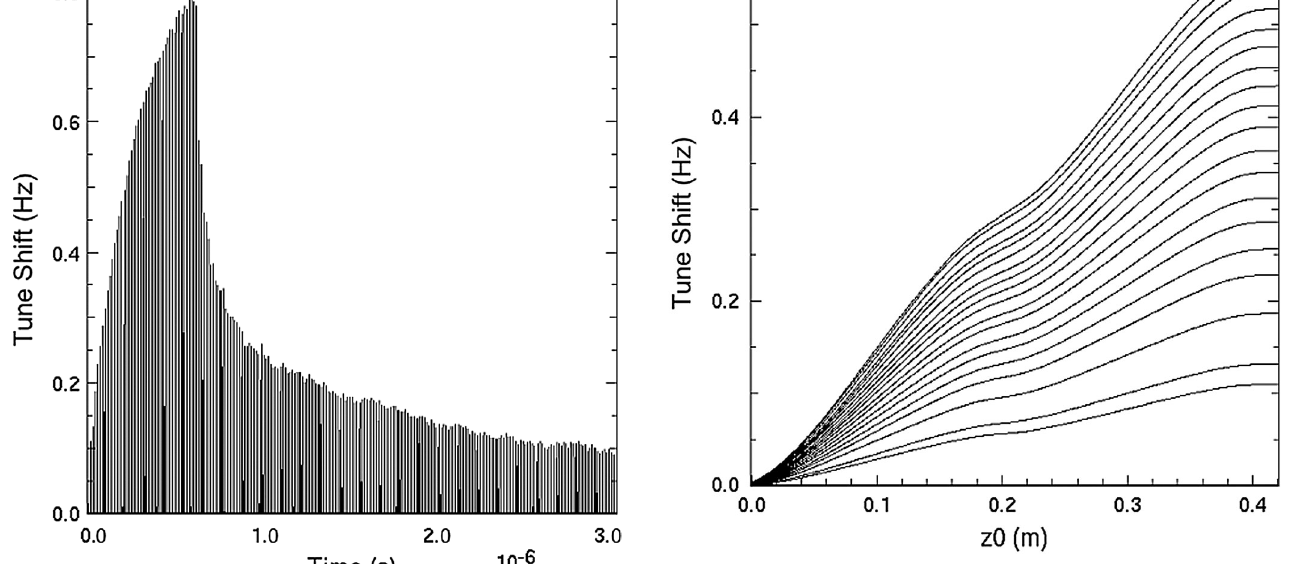
FIG. 16. y coherent tune shift vs time for the beam passage through one wiggler period (0.4 m) calculated using a 45-bunch train. The tune shift for each bunch is shown. See text for interpretation beyond bunch 45.